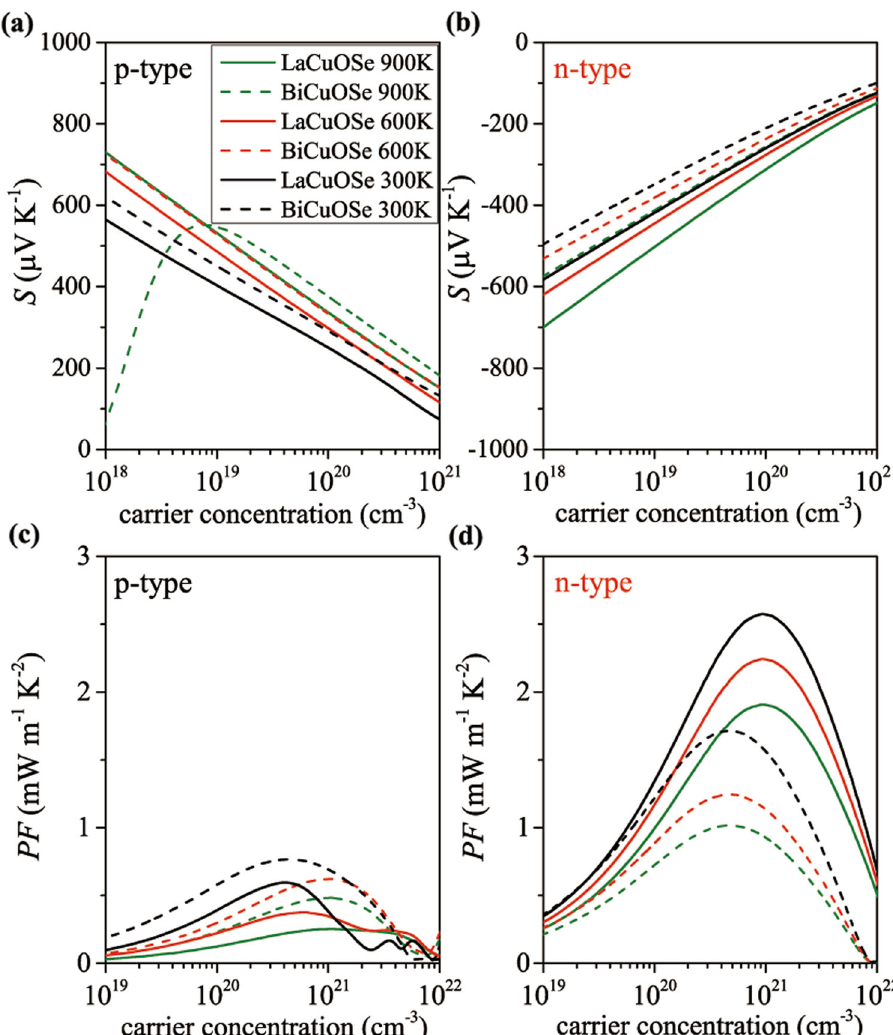
Fig. 4 Seebeck coef fi cient and power factor. The Seebeck coef fi cients ( a , b ) and power factors ( c , d ) for BiCuOSe and LaCuOSe as a function of carrier